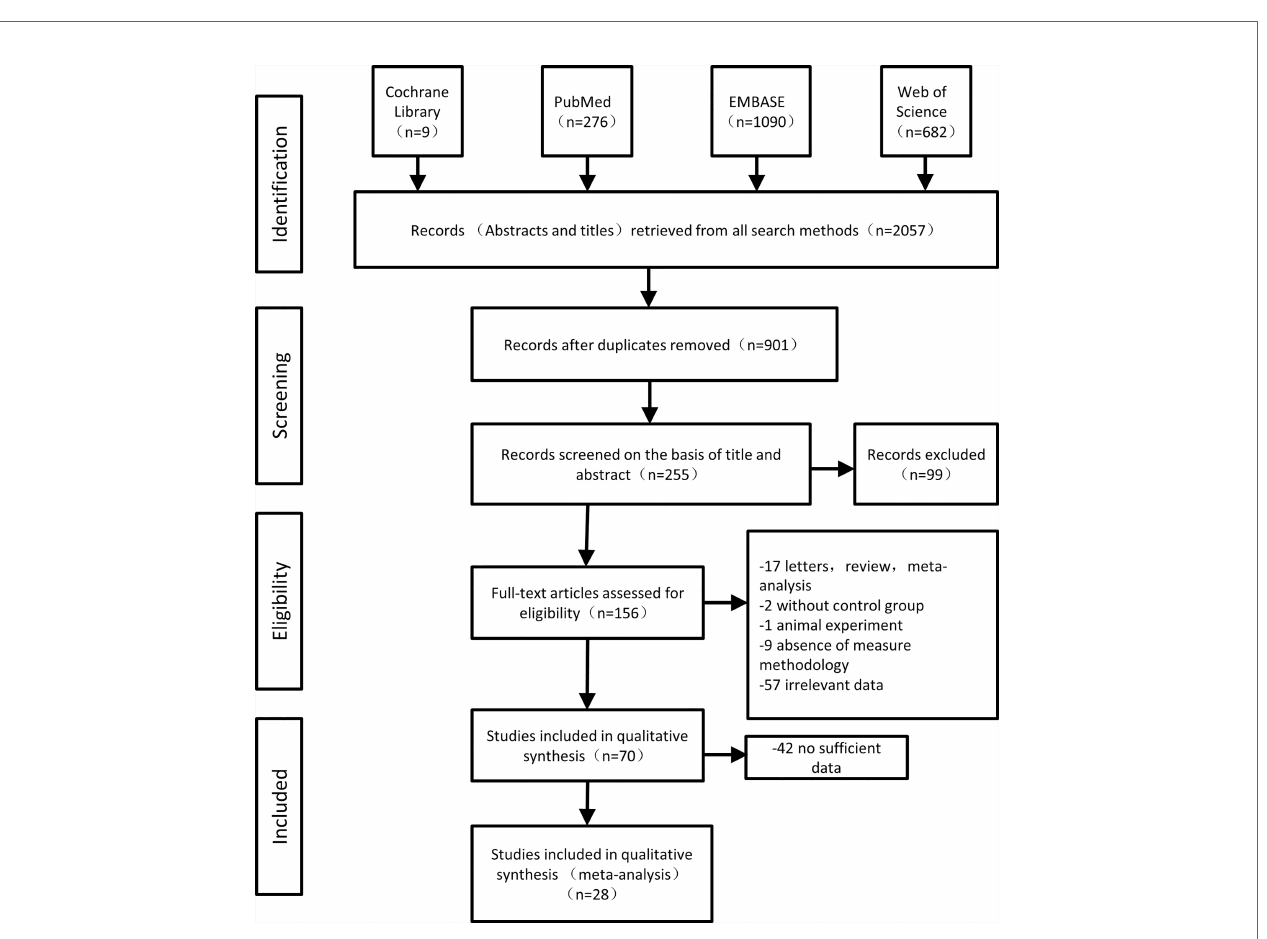
FIGURE 1 | The fl ow diagram of the selection of the